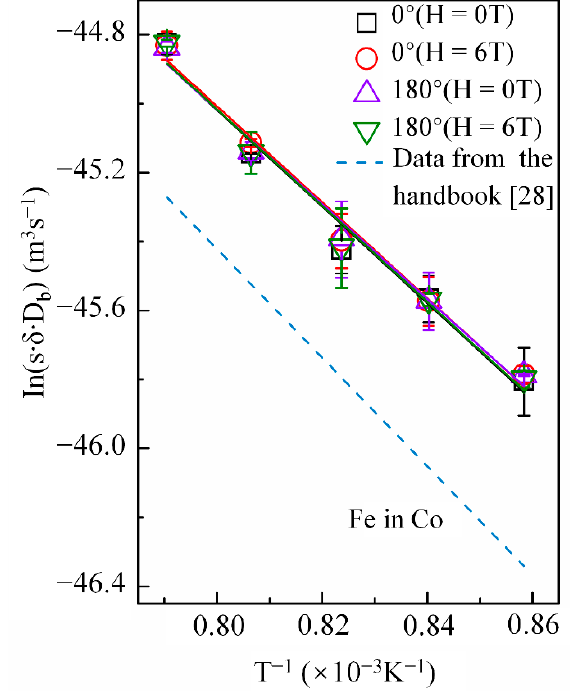
Figure 6. Arrhenius plots for grain boundary diffusivity of copper in cobalt with and without a high magnetic field. The angle between the magnetic field direction and the cobalt diffusion direction is 0 ◦ or 180 ◦ . The same type of the line with respect to the grain boundary diffusion data of iron in cobalt [28] was drawn by the dashed line. Table 3. Frequency factor ((cid:1871)(cid:2012)(cid:1830) (cid:3029) ) (cid:2868) and activation energy Q (standard deviation for 95% confi- dence) for copper grain boundary diffusivities in cobalt under a nonmagnetic field and a 6-T mag- netic field.